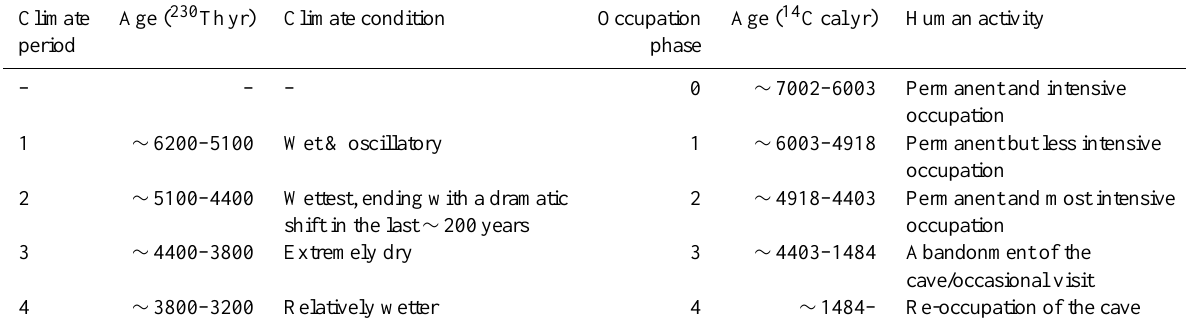
Table 3. Summary of the features of climate and human activity in different climate periods and occupation